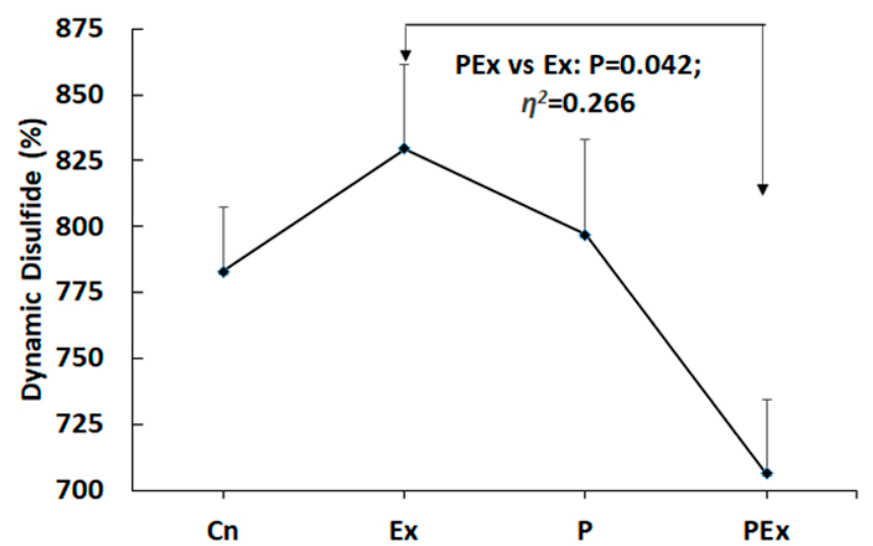
Figure 2. Total thiol levels. The total thiol level was found to be significantly higher in the EX group as compared with in the PEx group. The use of probiotics alone did not have any effect on the total thiol level.